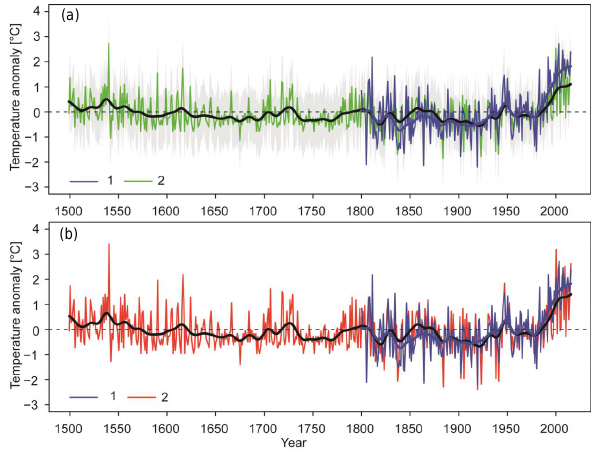
Figure 8. Measured (1) and reconstructed (2) mean Czech April– August temperatures in the 1499–2015 period using linear regres- sion (a) and variance scaling (b) ; temperatures indicate anomalies with respect to the 1961–1990 period. Thick blue and black lines represent measured and reconstructed temperatures smoothed by Gaussian filter for 30 years; grey area approximates 95% confi- dence interval constructed as two units of standard error (SE) of the estimate from the linear